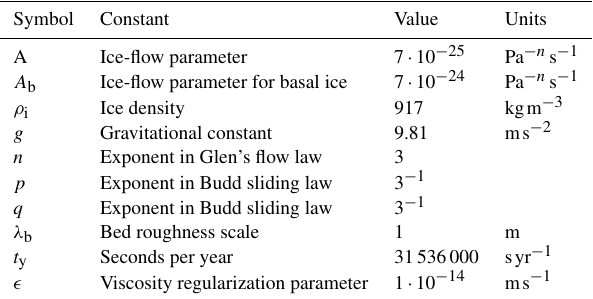
Table 1. Constants used in the ice-sheet–inversion model applied to the Russell Glacier